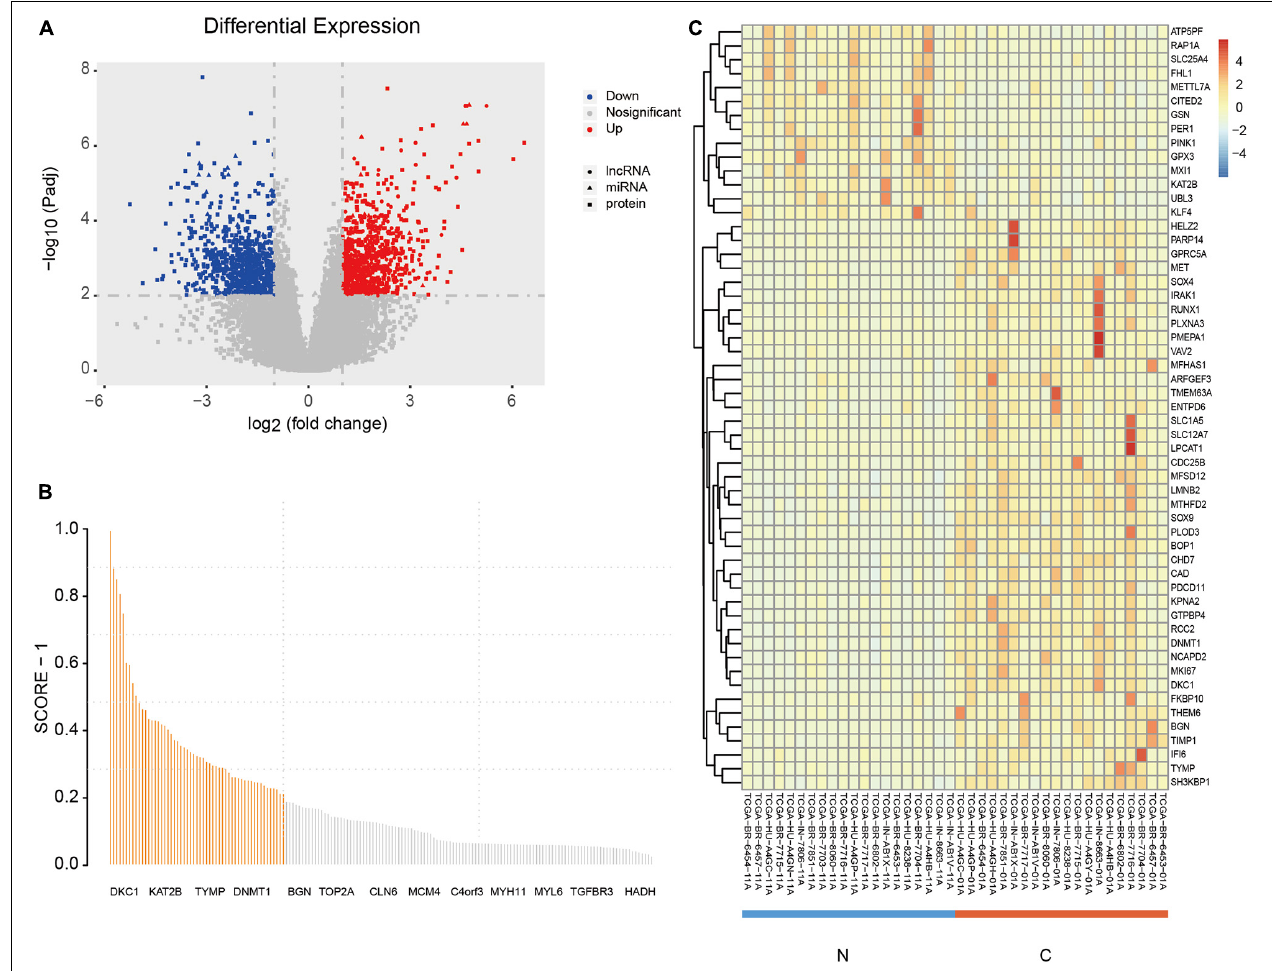
FIGURE 2 | DE RNAs and the screening results of PmBs. (A) Volcano plot of DE RNAs (circles: DE mRNA, squares: DE miRNA, triangles: DE lncRNA); red dots represent up-regulated DE RNAs, and blue dots represent down-regulated DE RNAs. (B) The total information amount plot of DE mRNAs; the abscissa represents symbols of mRNA (part of the symbols is displayed), and the ordinate is the total information amount of each DE mRNA. (C) Heatmap of the PmBs of adjacent normal group vs. GA group. DE, differentially expressed; PmBs, potential mRNA biomarkers; N, adjacent normal sample; C, cancer sample; TIA, total amount of